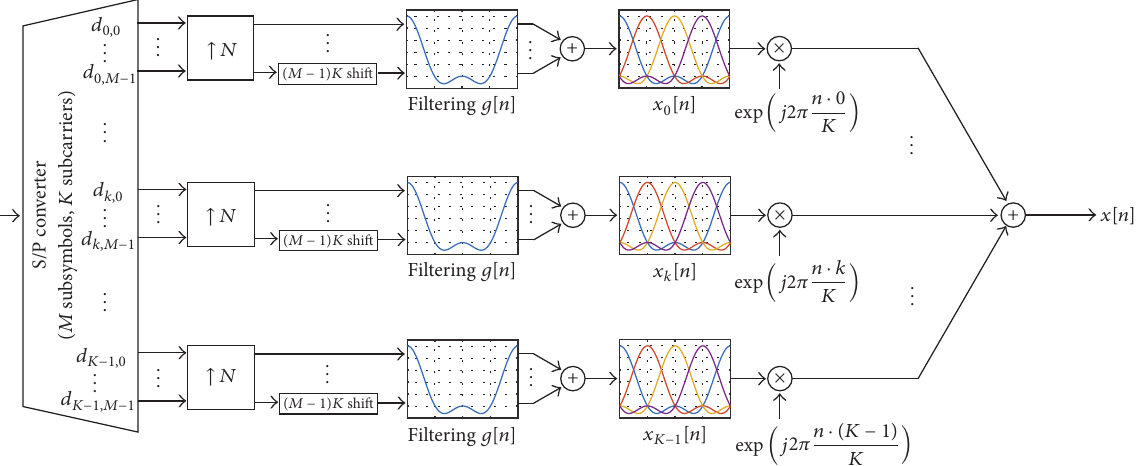
Figure 3: GFDM modulation block diagram.